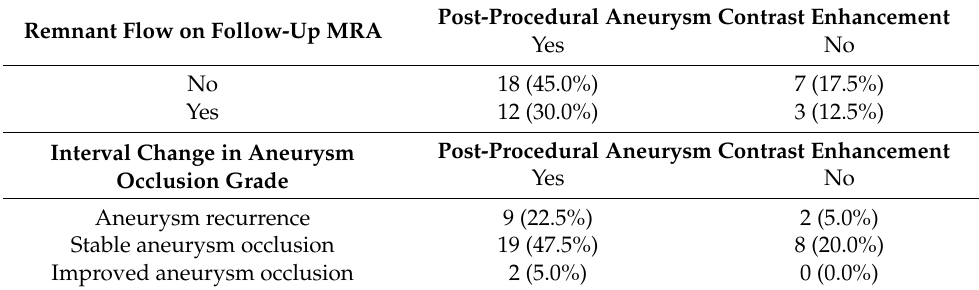
Table 3. Post-procedural aneurysm contrast enhancement and aneurysm occlusion grade.